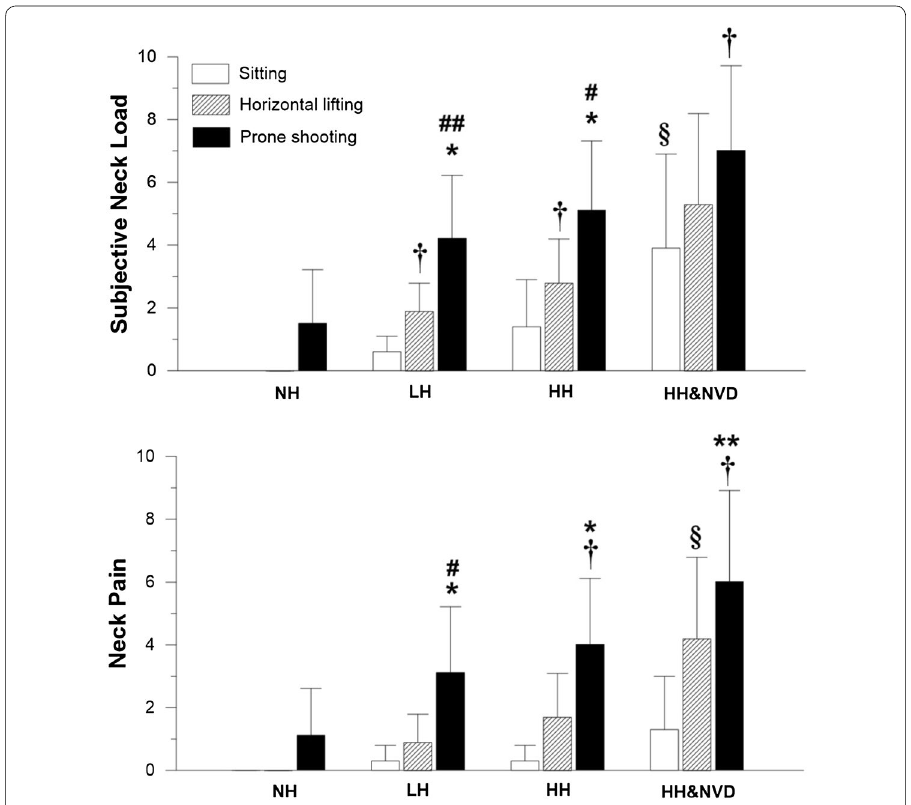
Fig. 3 Effects of helmets and postures (resting, moving boxes, prone shooting) on the subjective neck load and neck pain. They were rated with a visual analogue scale from 0 (no neck load), to 10 (intolerable neck load) or a scale from 0 (no pain) to 10 (intolerable neck pain). * P < 0.05 and ** P < 0.01 indicate the posture effects versus sitting; # P < 0.05 and # P < 0.01 indicate the posture effects versus horizontal lifting; † P < 0.05 indicates the helmet effects versus NH; § p < 0.05 indicates the helmet effects versus LH. All significances were verified by non-parametric statistics: Friedman test was used to identify the group differences with